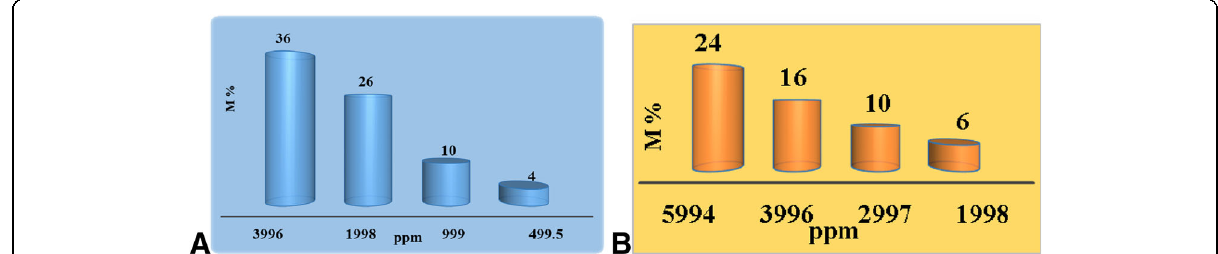
Fig. 7 The mortality percentage of fourth-instar larvae for AgNPS to a laboratory and b field strains of Spodoptera